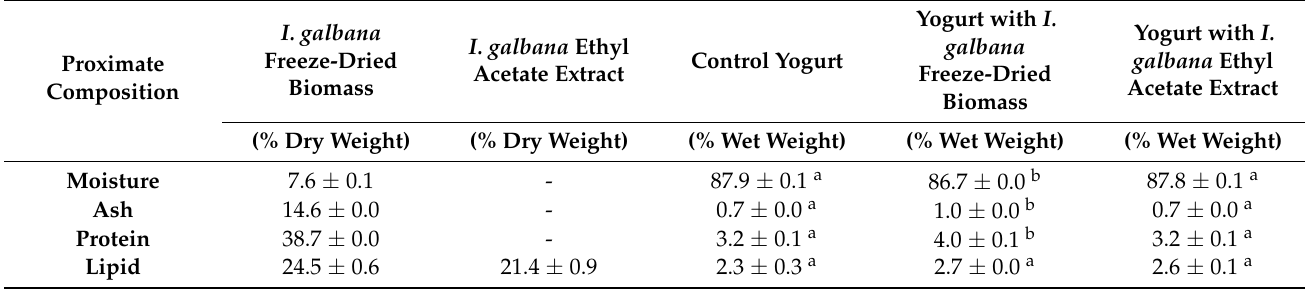
Table 1. Proximate composition (%) of I. galbana freeze-dried biomass, I. galbana ethyl acetate extract, control yogurt, yogurt with 2% ( w / w ) of I. galbana freeze-dried biomass, and yogurt with 2% ( w / w ) of I. galbana ethyl acetate extract.